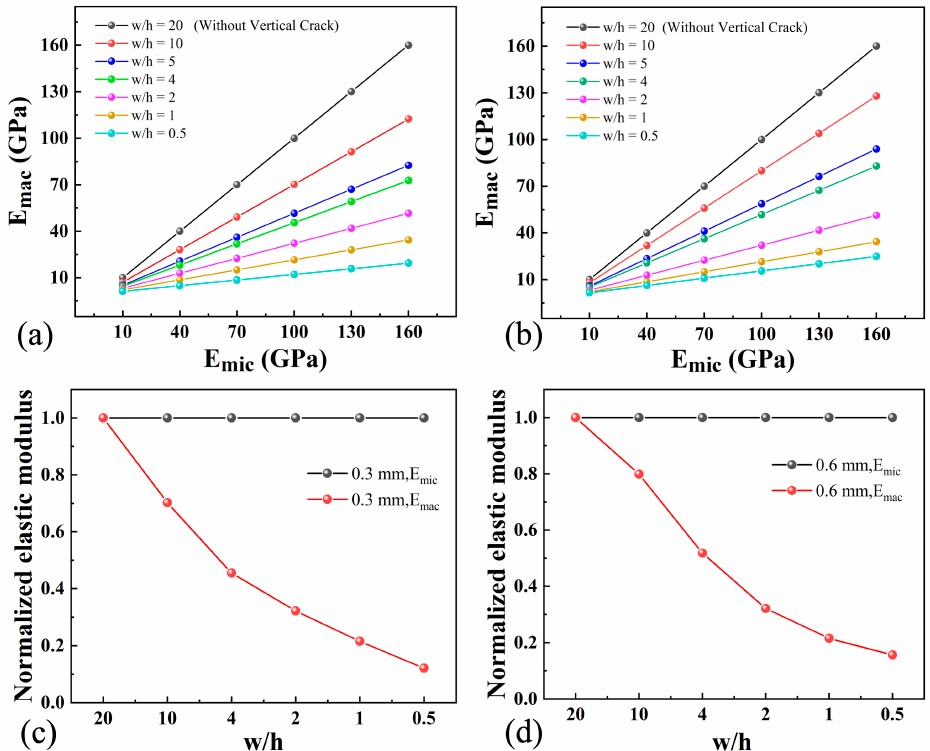
Figure 16. Effect of vertical cracks on macroscopic elastic modulus ( a ) 0.3 and ( b ) 0.6 mm thick TCs. Effect of vertical cracks on the stiffening effect on ( c ) 0.3 and ( d ) 0.6 mm thick TCs. Multiscale pores can prevent macroscopic stiffening in TBCs, resulting in much lower SERR for cracking. Herein, the sintering-resistant design is analyzed. The macroscopic elastic modulus of the vertically cracked structure was used as input data for the simula- tion, which is equivalent to models with vertically cracked structures. In this way, the sintering-resistant effect of the TBC model after inducing vertical cracks could be ob- tained. As shown in Figure 17, the peak tensile and shear stresses at the crack tip of TC with different thicknesses decrease. When w/h decreases from 10 to 0.5, SERR of the 0.3, 0.6, and 0.9 mm thick TCs decreases by 79.9% (Figure 18a), 83.8% (Figure 18b), and 84.1% (Figure 18c), respectively. This result is consistent with that obtained in the previous sec- tion. Therefore, the implantation of vertical cracks can reduce the overall stiffening of TBCs, increase its strain tolerance, reduce the driving force for cracks, and extend the life span of TBCs.